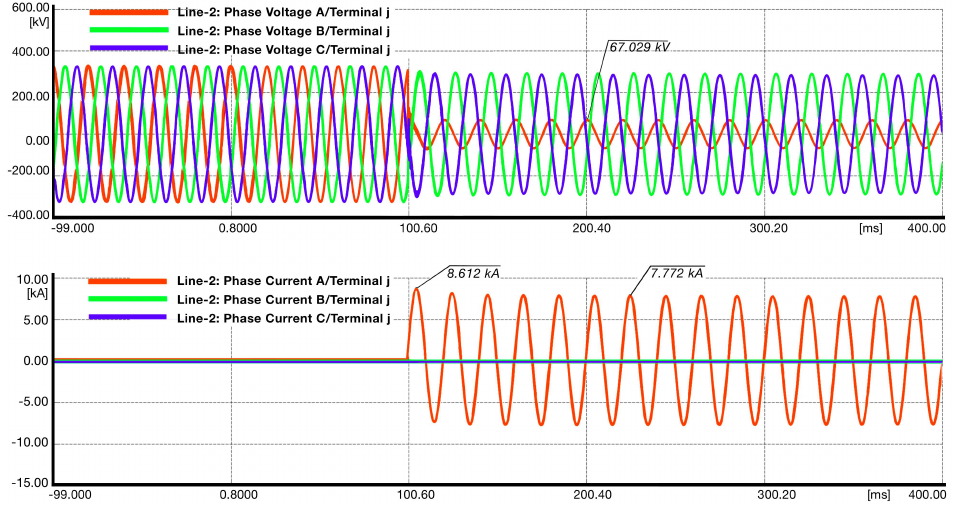
Figure 5. Three-phase voltages and currents for a single phase–ground fault.